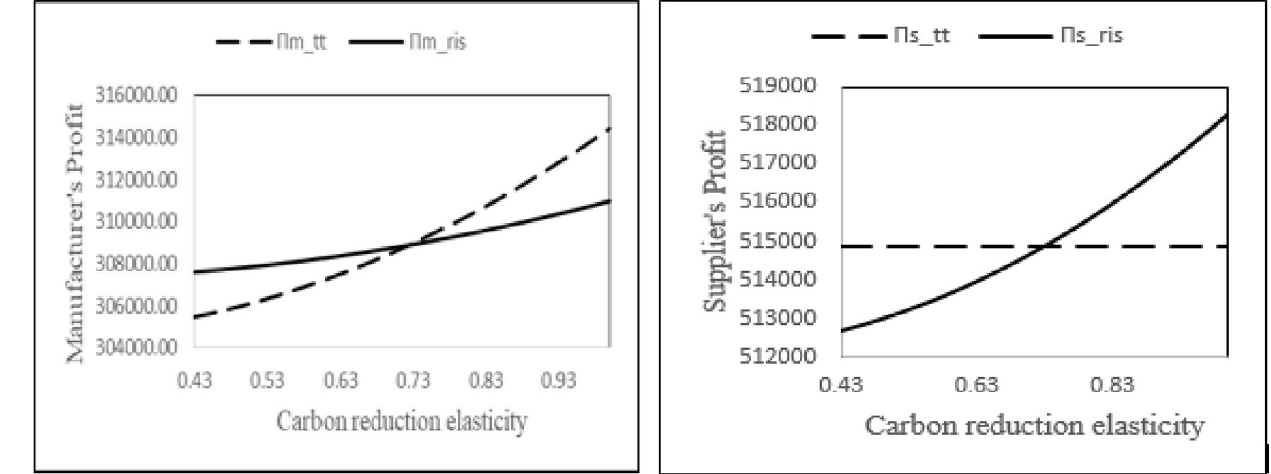
Fig 3. Comparison of manufacturer’s and supplier’s profit in two contracts w.r.t. the carbon reduction elasticity ( γ ).